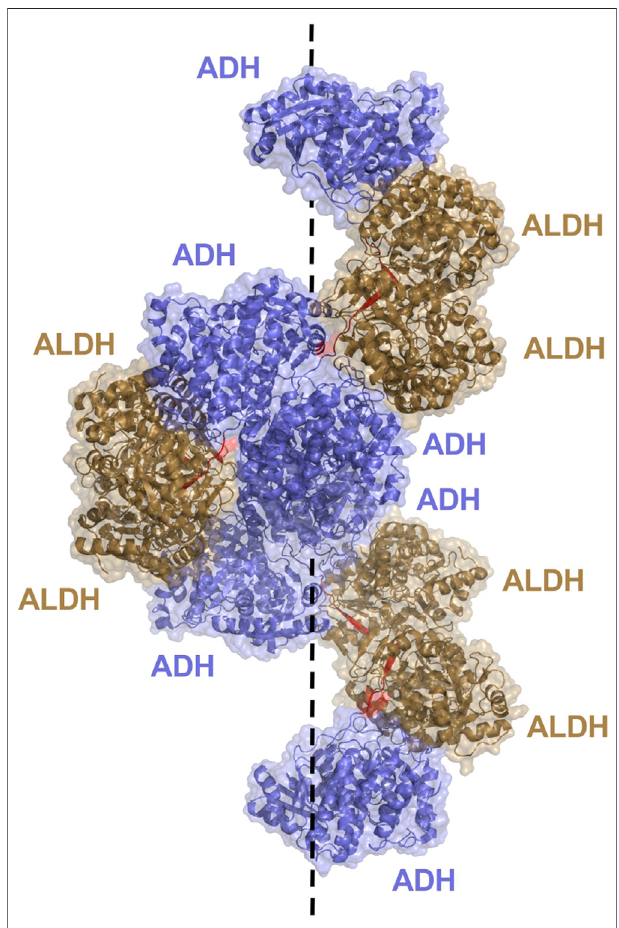
FIGURE 9 | AdhE extended spirosome structure shown as a cartoon with transparent surface representation (PBD: 7BVP). ALDH domains located ontheoutersurfaceareshowninbrown,ADHdomainsinblueontheinsideof the spirosome and the 7 amino acid linker between domains in red. The dotted line demonstrates the helical axis of the